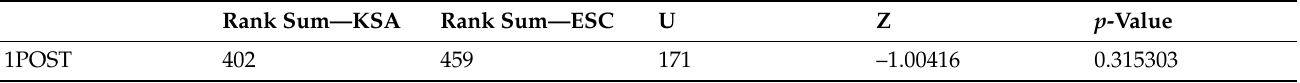
Table 5. Mann–Whitney U test for item 1POST.